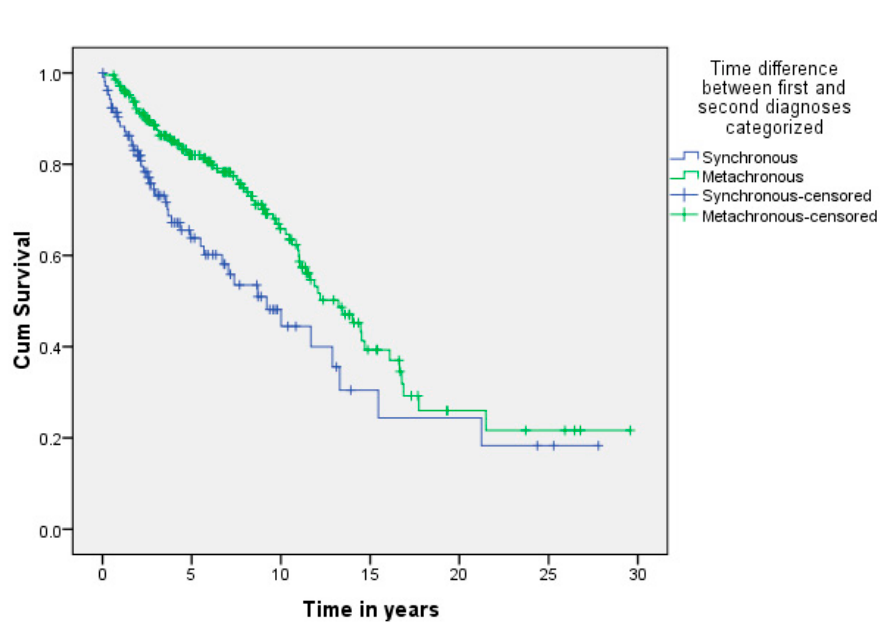
Figure 6. Shows the difference in survival of patients with synchronous and metachronous malignancies. The median survival time was 9.2 ± 1.7 and 13.2 ± 1.2 years for synchronous and metachronous malignancies, respectively, and the difference was statistically significant ( p = 0.002).